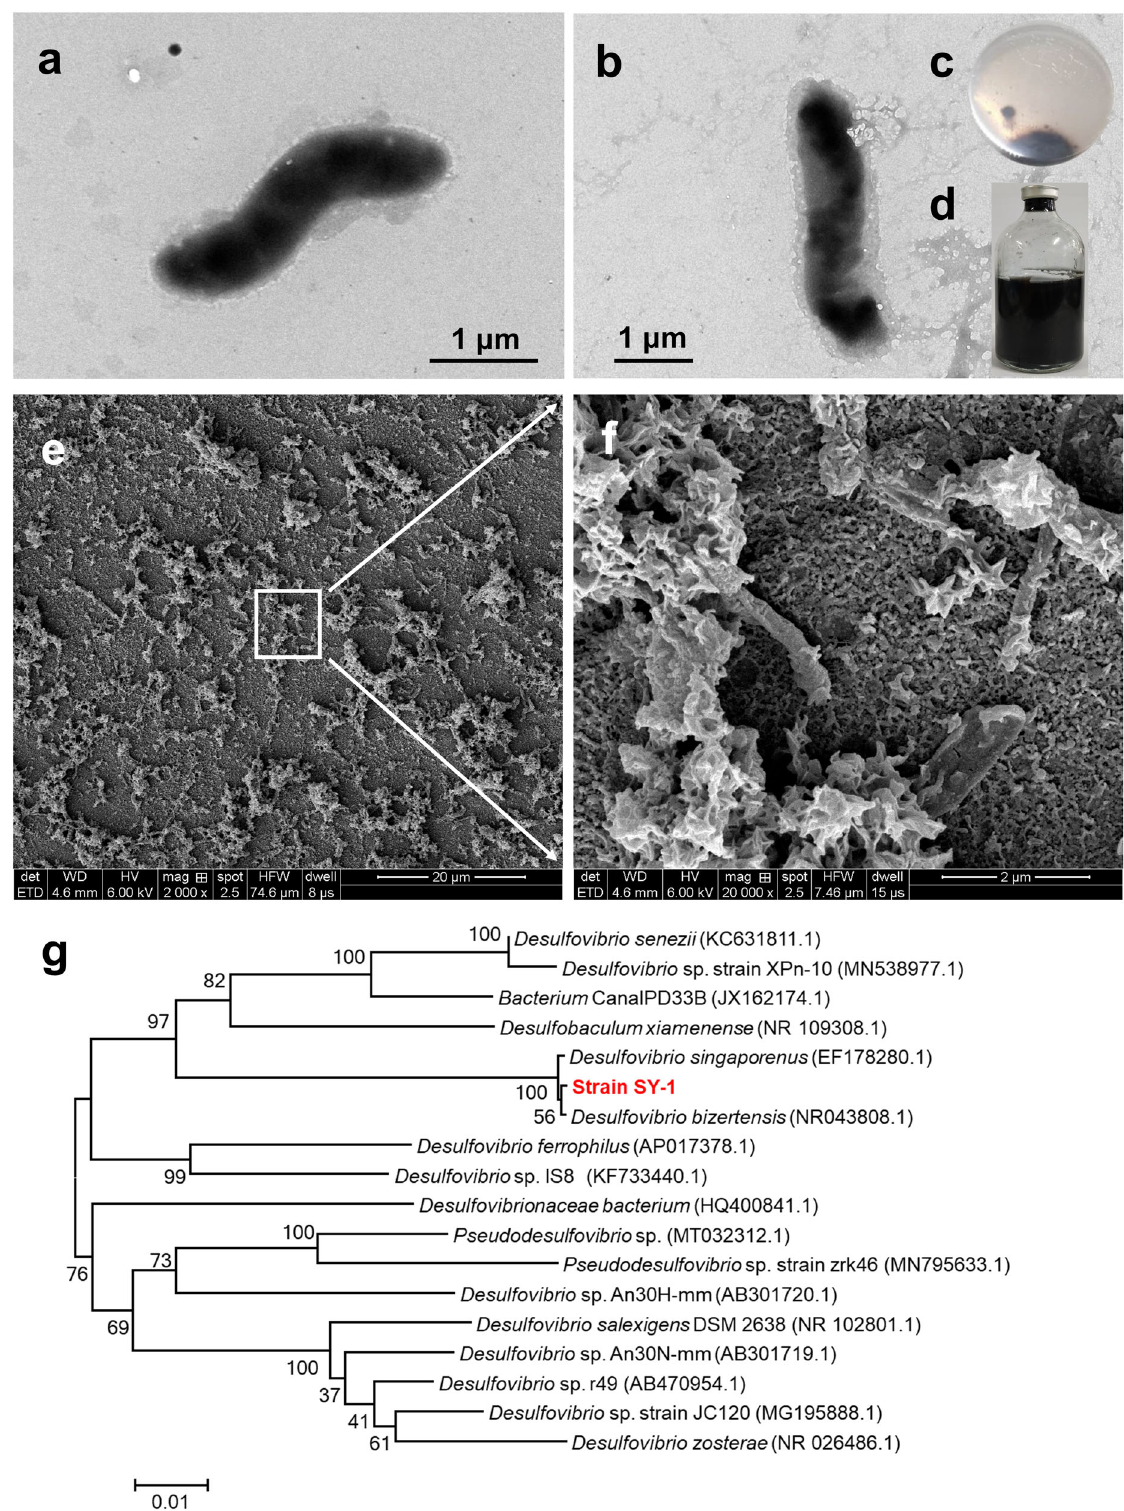
Fig. 6 Isolation and cultivation of D. bizertensis SY-1 from the rust layers. a , b TEM images of SY-1 strain, c , d optical images of SY-1 strain on solid agar plates and in liquid medium, e , f SEM images of the corrosion products of Q235 exposed in SY-1 media for 15 days, and g phylogenetic relationship between the 16S rDNA sequences from the